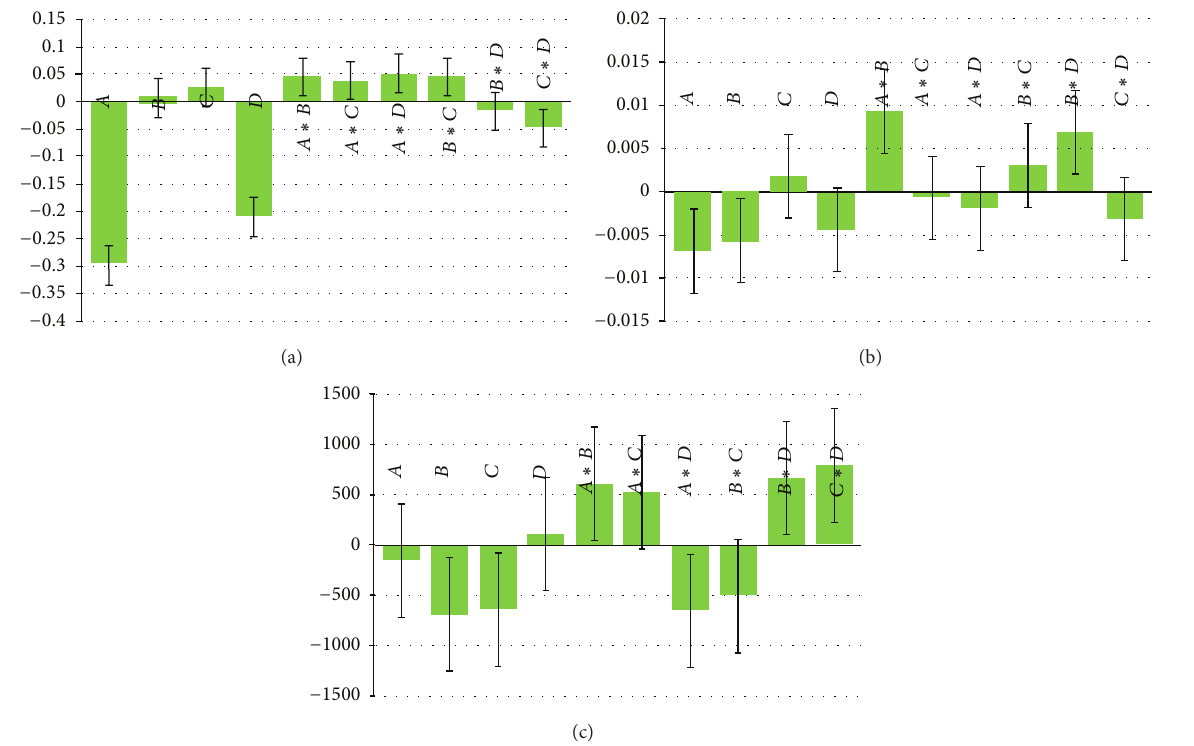
Figure 3: Scaled and centered coefficient of variation (%) of (a) retention time ( 𝑇 𝑟 ), (b) tailing factor of drug ( 𝑇 𝑓 ), and (c) area count.